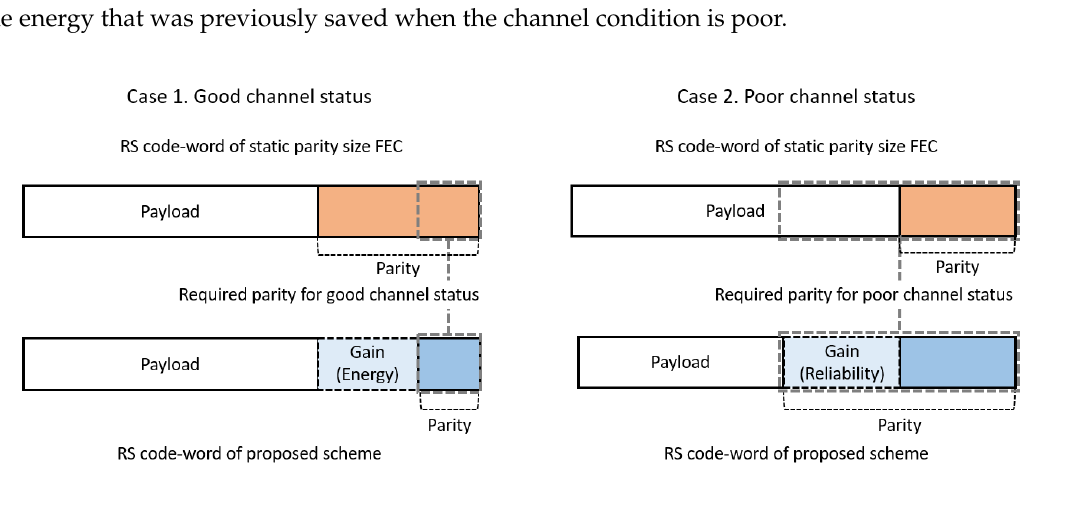
Figure 7. Comparison with FEC using fixed